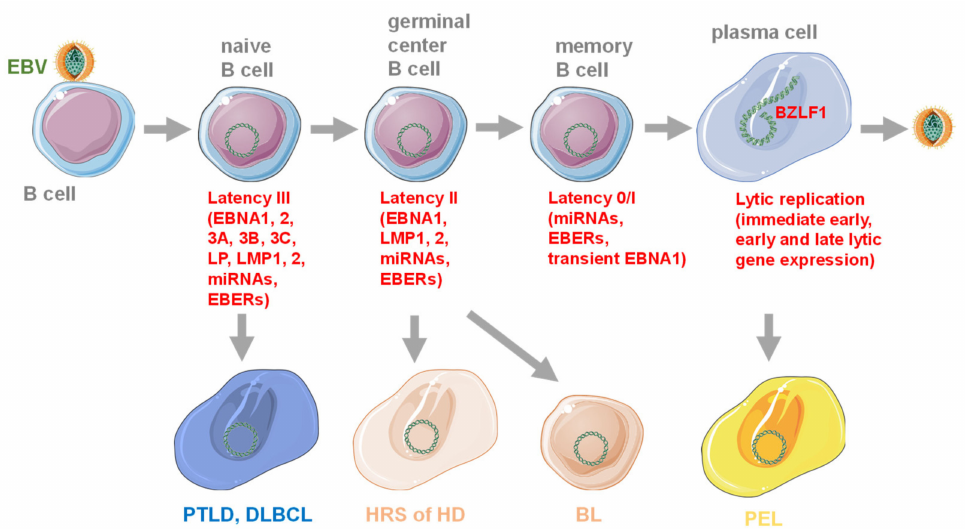
Figure 1. Epstein–Barr (EBV) associated B cell lymphomas emerge from di ff erent stages of EBV infection. Latency III with the indicated latent viral gene expression can be found in naïve B cells of healthy virus carriers, from which post-transplant lymphoproliferative disease (PTLD) and di ff use large B cell lymphoma (DLBCL) are thought to emerge. Reduced latency II viral gene expression is